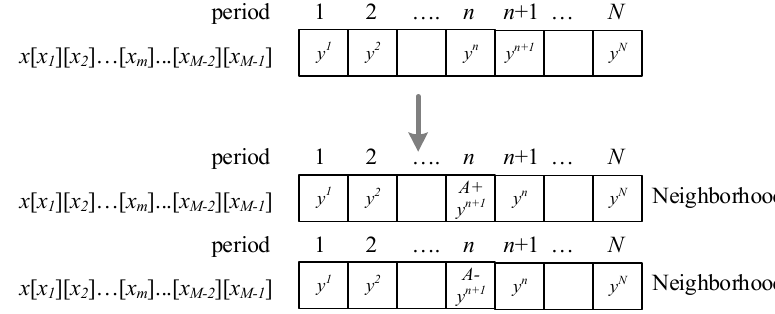
Fig. 6 . Mixed swapping and mutation operations of